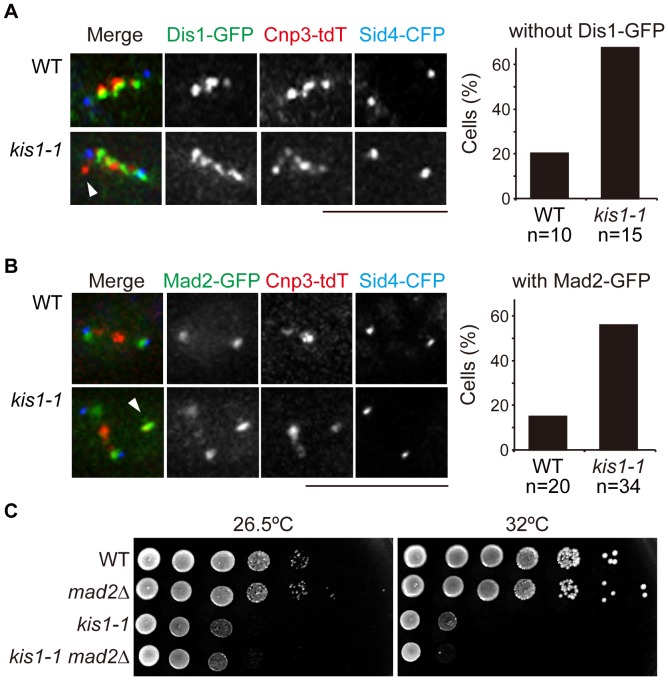
Spindle organization in kis1-1.(A) Dis1 was not loaded onto unattached kinetochores in kis1-1. Left: Dis1-GFP was visualized together with Cnp3-tdTomato and Sid4-CFP in WT and kis1-1 cells after growth at 36°C for 6–9 h. Arrowheads indicate a kinetochore without Dis1-GFP. Right: Percentages of mitotic cells having one or more kinetochores without Dis1-GFP. (B) Mad2-GFP localized to unattached kinetochores in kis1-1. Left: Mad2-GFP in WT and kis1-1 cells was observed with Sid4-CFP and Cnp3-tdTomato after growth at 36°C for 6–9 h. Arrowheads indicate kinetochores with Mad2-GFP. Right: Percentages of metaphase cells bearing Mad2-GFP dots at kinetochores. n: The number of cells analyzed. Scale bar, 5 µm. (C) Ten-fold serial dilutions of the indicated strains spotted on YE5S at 25 or 32°C.